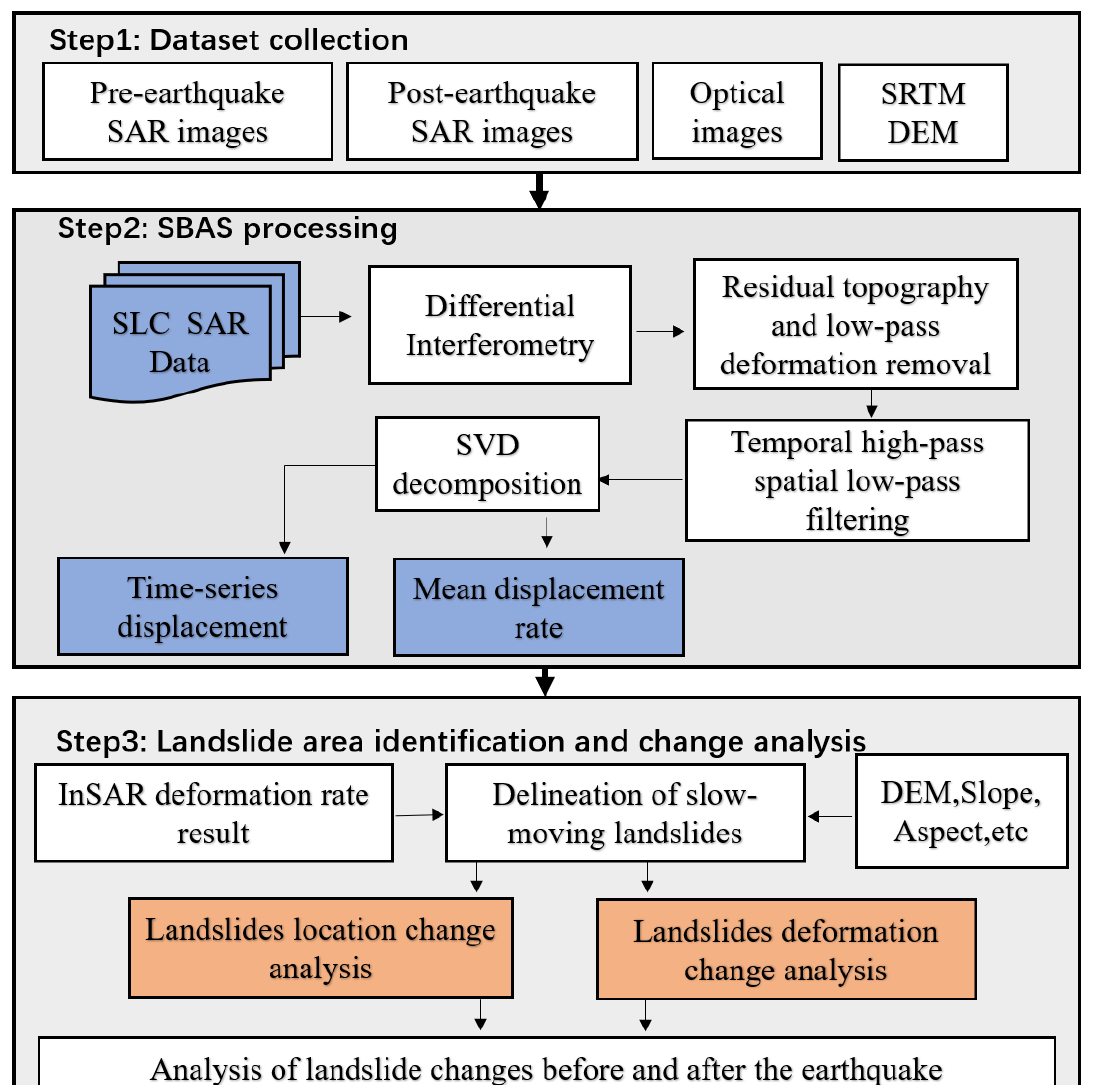
Figure 4. Main flow chart framework in this study.